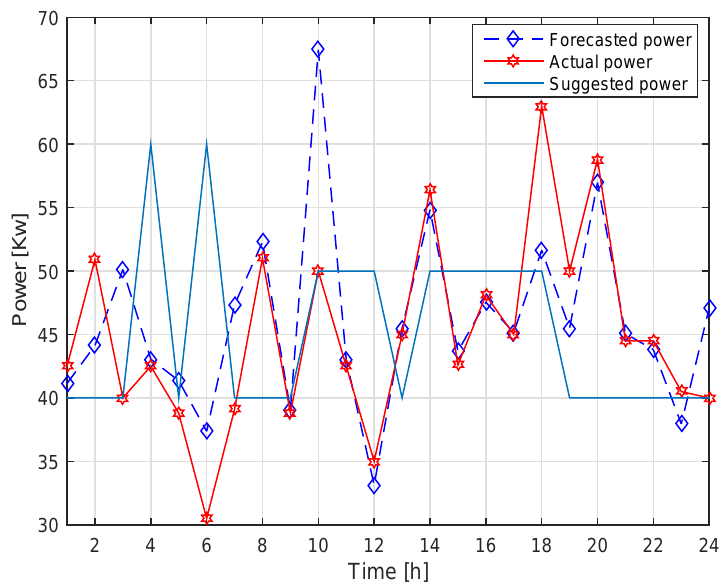
Figure 7. 24-h load forecast in comparison with output by LBPP.